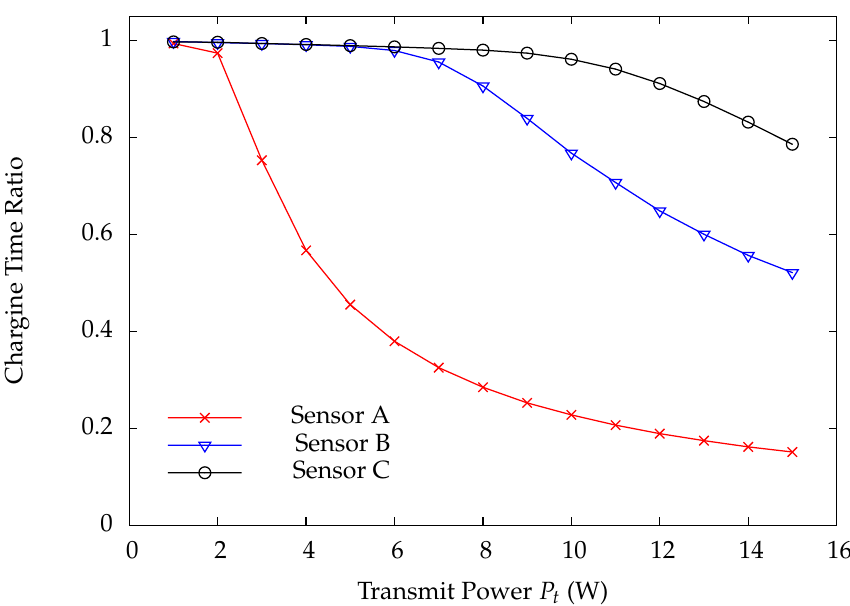
Figure 15. Charging time ratio versus transmit power P t